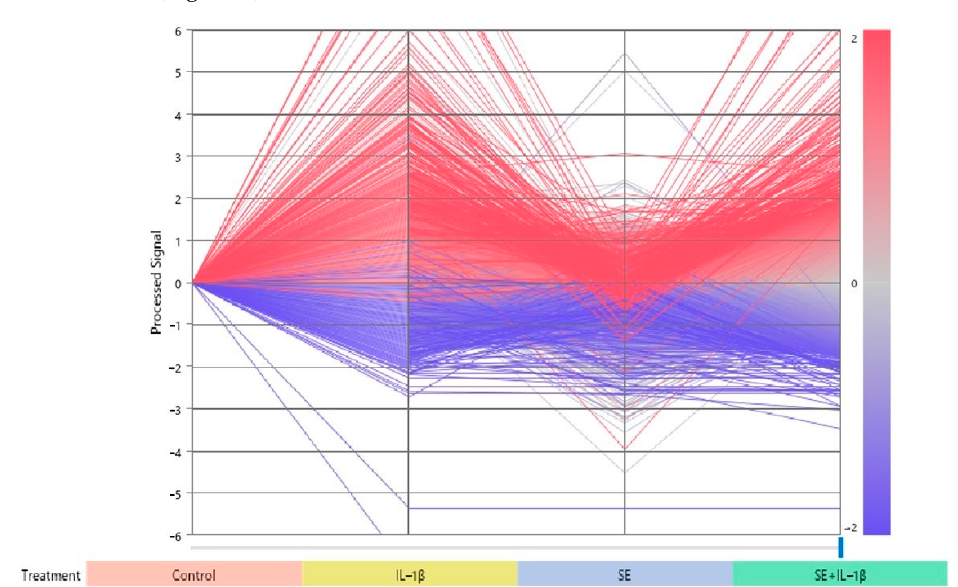
Figure 4. The expression intensity of each sample was expressed in a logarithmic scale using a line graph as a reference for control. In total, 16,405 spots with fluctuations of Log 2 (2) or more compared to the control were analyzed. Genes with higher mean expression intensity compared to the control are shown in red, and genes with lower mean expression intensity are shown in blue.